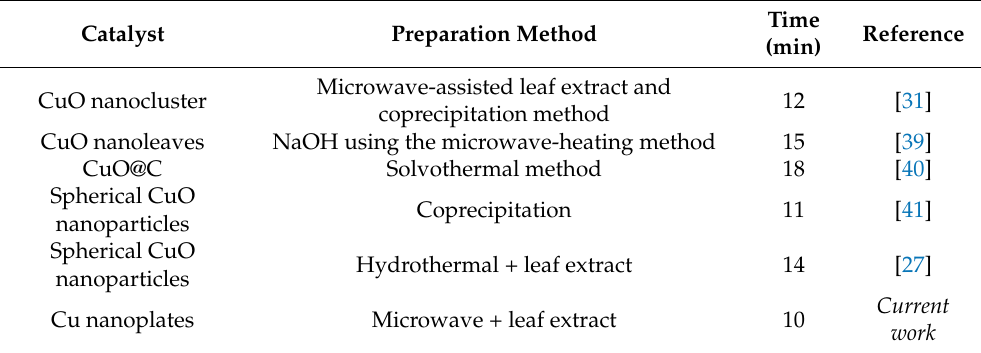
Table 1. Comparison of the catalytic activity of CuO NPs with the previously reported CuO-based catalysts for the reduction of 4-NP.